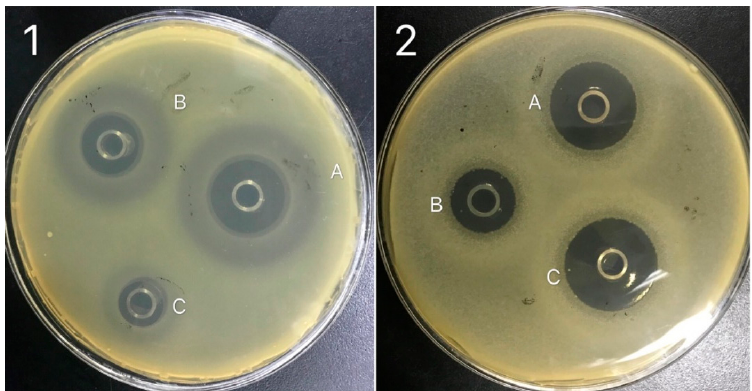
Figure 7. Inhibition zone of pathogenic bacteria, ( 1 ) Staphylococcus aureus , ( 2 ) Escherichia coli. ( A ) NT-5, ( B ) NT-6 and ( C ) NT-7.